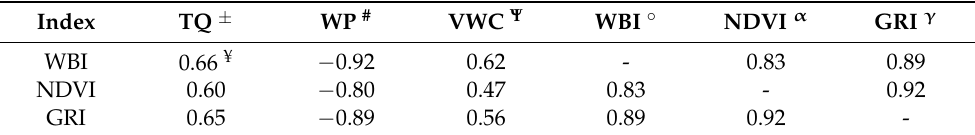
Table 1. Pearson correlation coefficients ( r ) of vegetation indices to turf quality (TQ), wilt percent (WP), soil volumetric water content (VWC) and vegetation indices derived from light reflectance data. Light reflectance data and other parameters collected from ‘007’ creeping bentgrass and ‘L-36’ hybrid bermudagrass grown in three soil textures and subjected to drought stress under greenhouse conditions in Blacksburg,